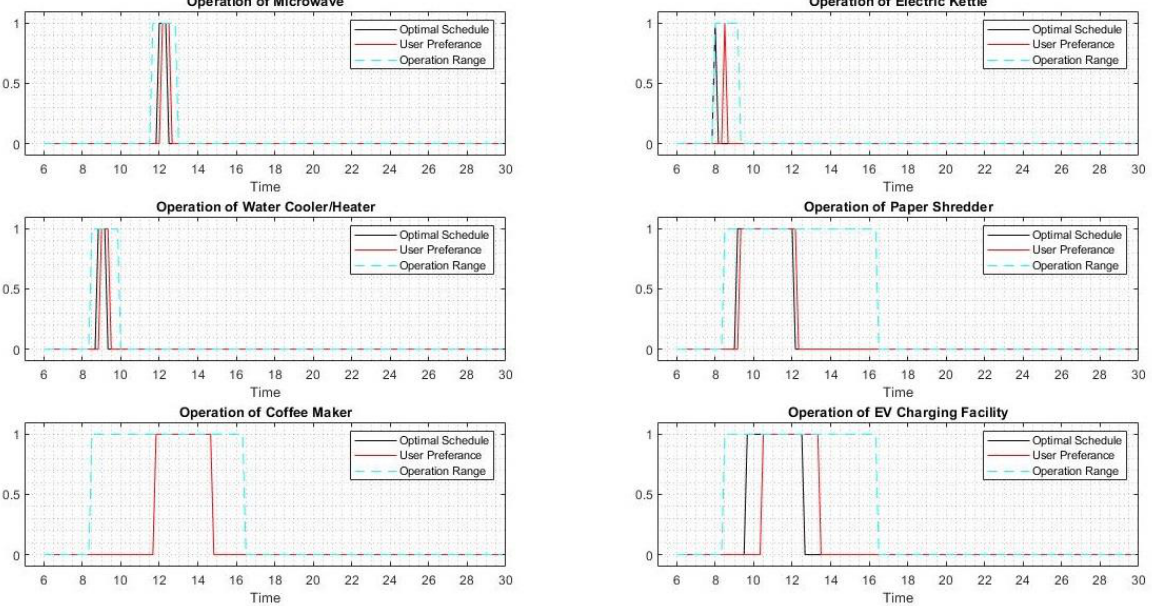
Figure 7. The operation of some assets in one of the office buildings where they collaborated.